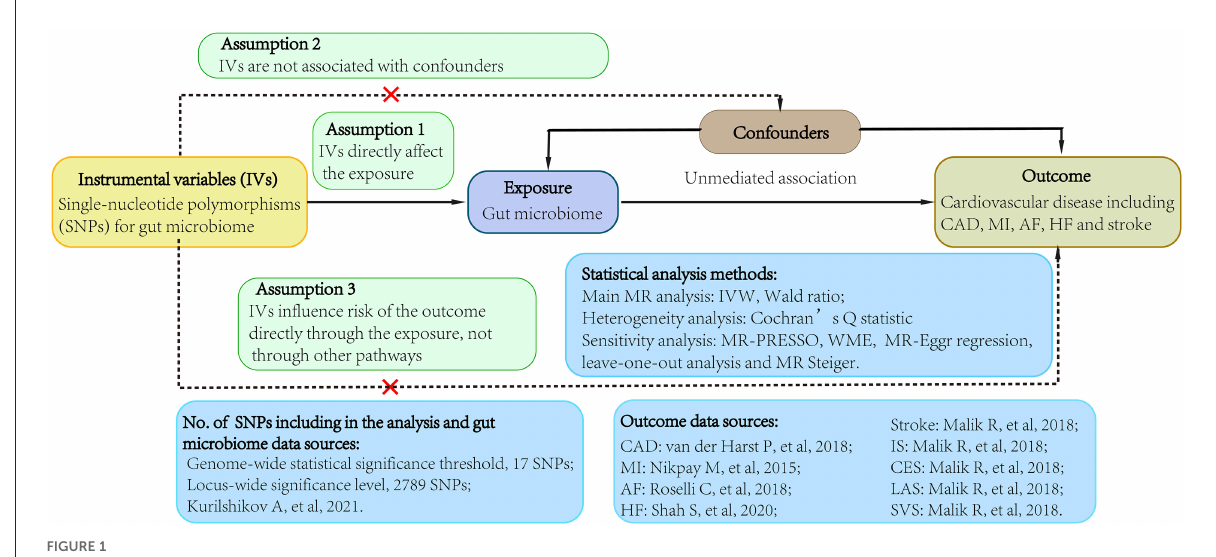
FIGURE1 Study flow diagram. Dashed lines indicate potential pleiotropic or direct causal effects between variables that may violate MR assumptions. IV, instrumental variable; CAD, coronary artery disease; MI, myocardial infarction; HF, heart failure; AF, atrial fibrillation; IS, ischemic stroke; CES, cardioembolic stroke; LAS, large-artery atherosclerotic stroke; SVS, small-vessel stroke; IVW, multiplicative random effects inverse-variance weighted; MR, Mendelian randomization; WME, weighted-median estimator; MR-PRESSO, MR pleiotropy residual sum and